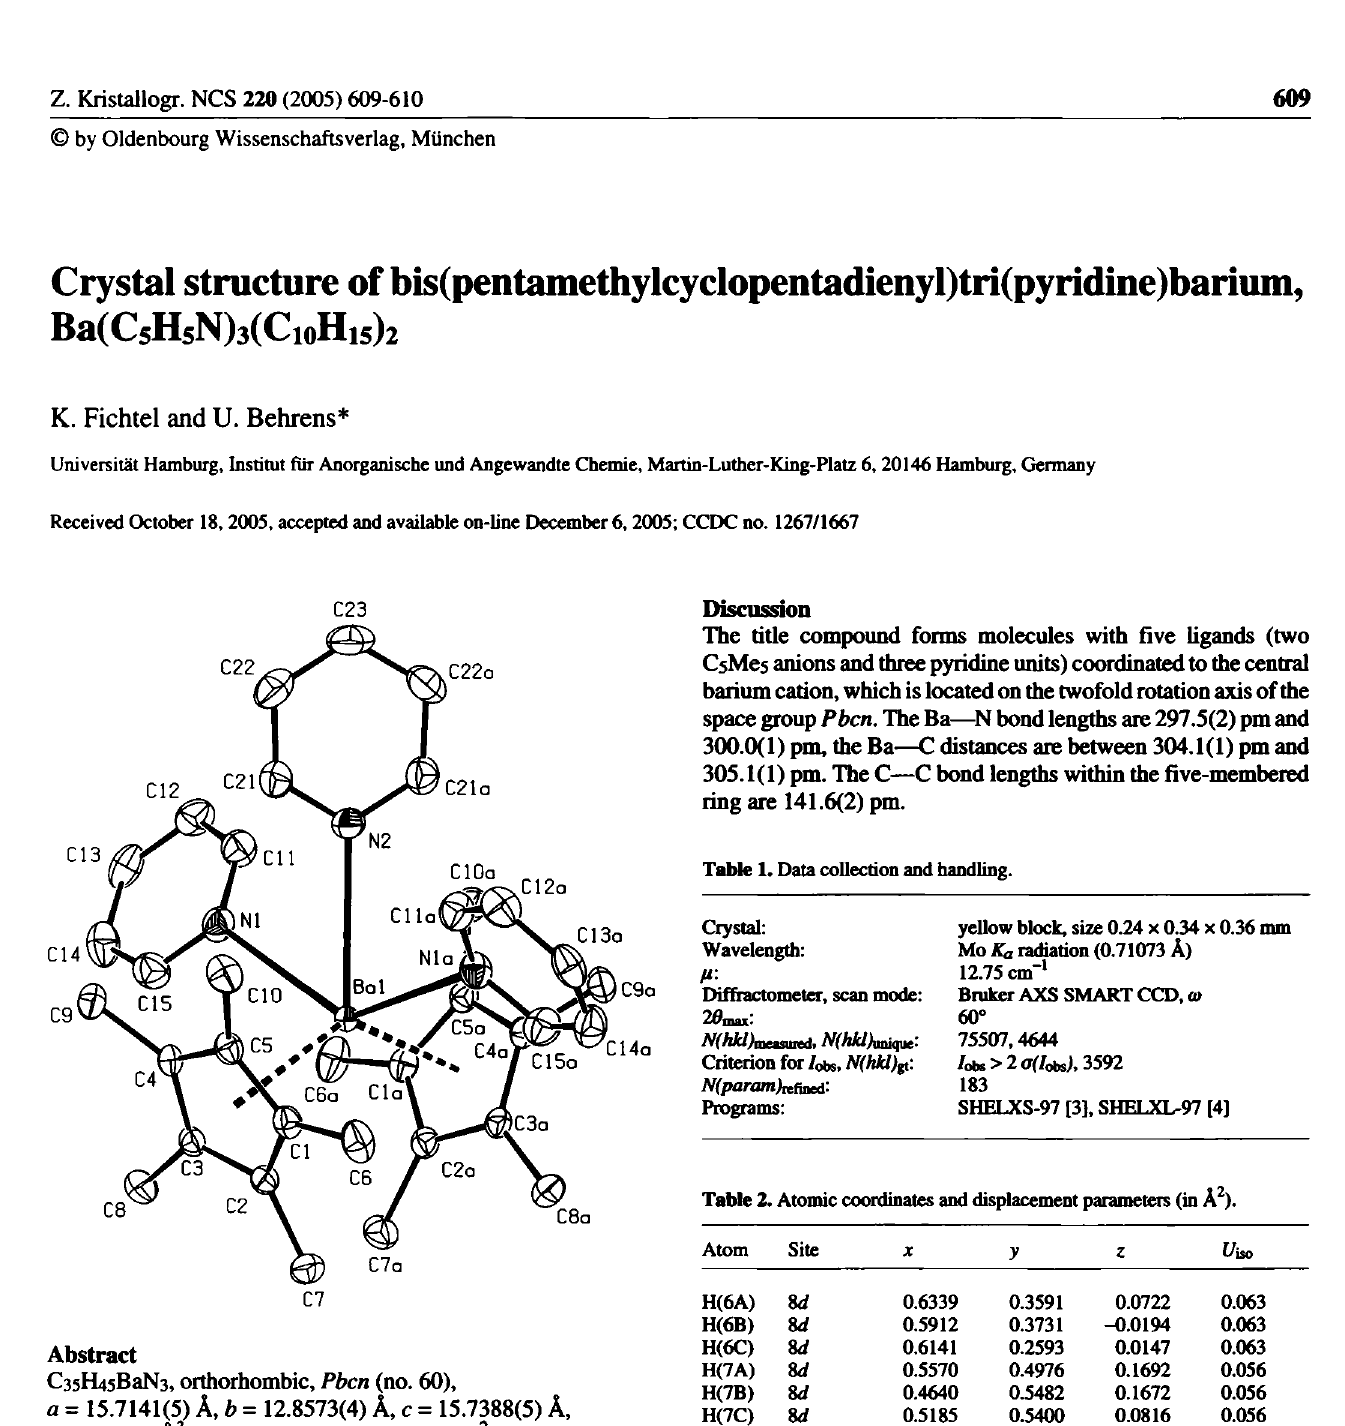
Table 2. Atomic coordinates and displacement parameters (in A 2